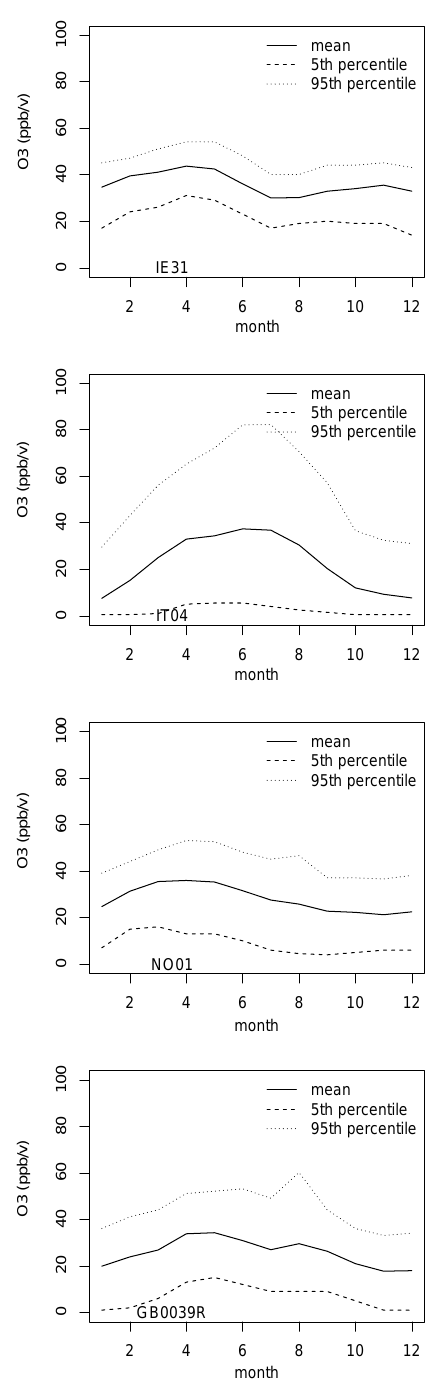
Fig. 7. Examples of seasonal cycles from IE31 [Mace Head], IT04 [Ispra], NO01 [Birkenes] and GB0039R [Sibton] showing from top to bottom examples of a spring maximum, broad spring–summer maximum, spring maximum with secondary summer maximum in 95th percentile and a spring and summer maxima in mean, 5th and 95th percentiles. All sites are available in Fig. A2 of the Supple- mentary information